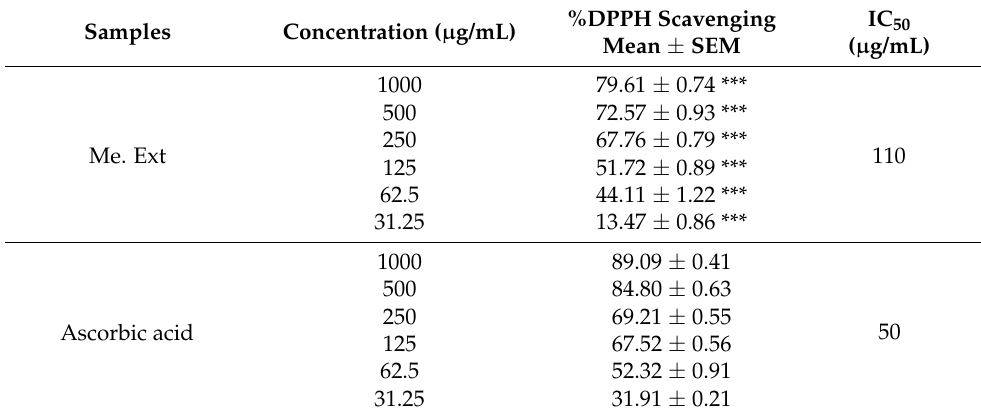
Table 5. Percentage DPPH free radical scavenging activity of root